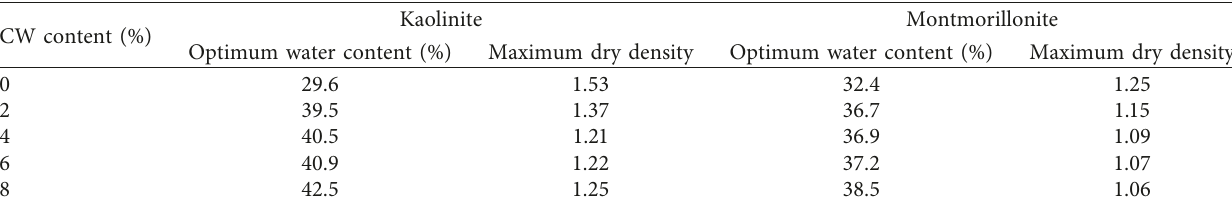
Table 4: Summary of compaction tests.